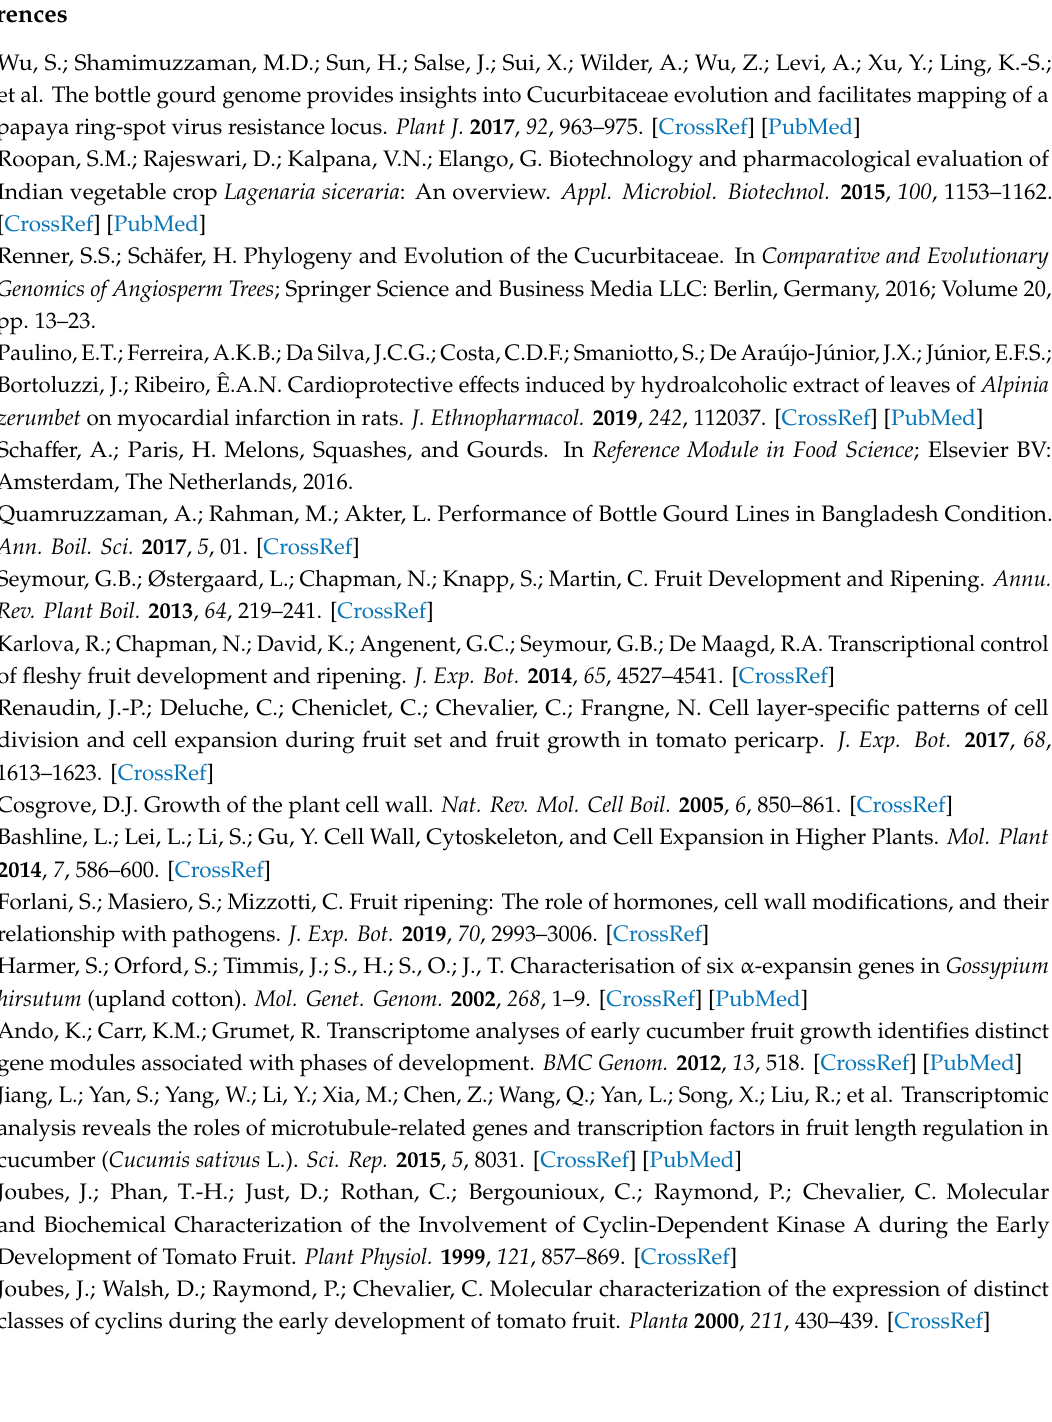
Table S1: Primer list of genes selected for qRT-PCR; Table S2 . List of the di ff erentially expressed genes between Hang and USA fruits; Figure S1 . Unigene length